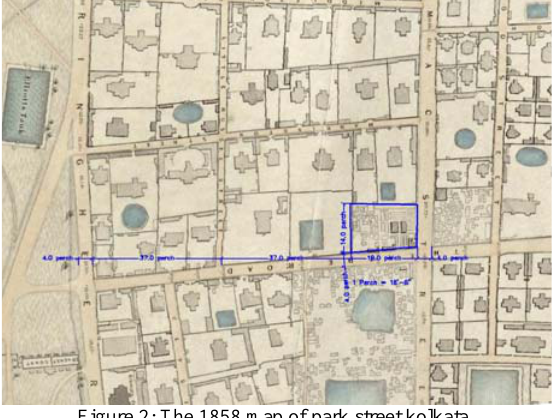
Figure 2: The 1858 map of park street kolkata In 1858, the plot accommodates a “bustee“ with mostly kaccha structures. The unit of measure is most probably the perch = 16’-6’’ (Source: Simms map , 1847 revised 1858)